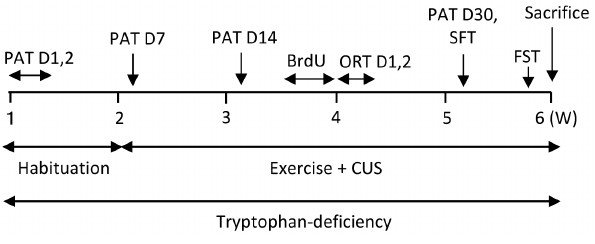
Figure 1. Experimental procedures. Habituation: habituation to cage, food and treadmill running; CUS: chronic unpredictable stress; PAT: passive avoidance test; ORT: object recognition test; SFT: sucrose preference test; FST: forced swimming